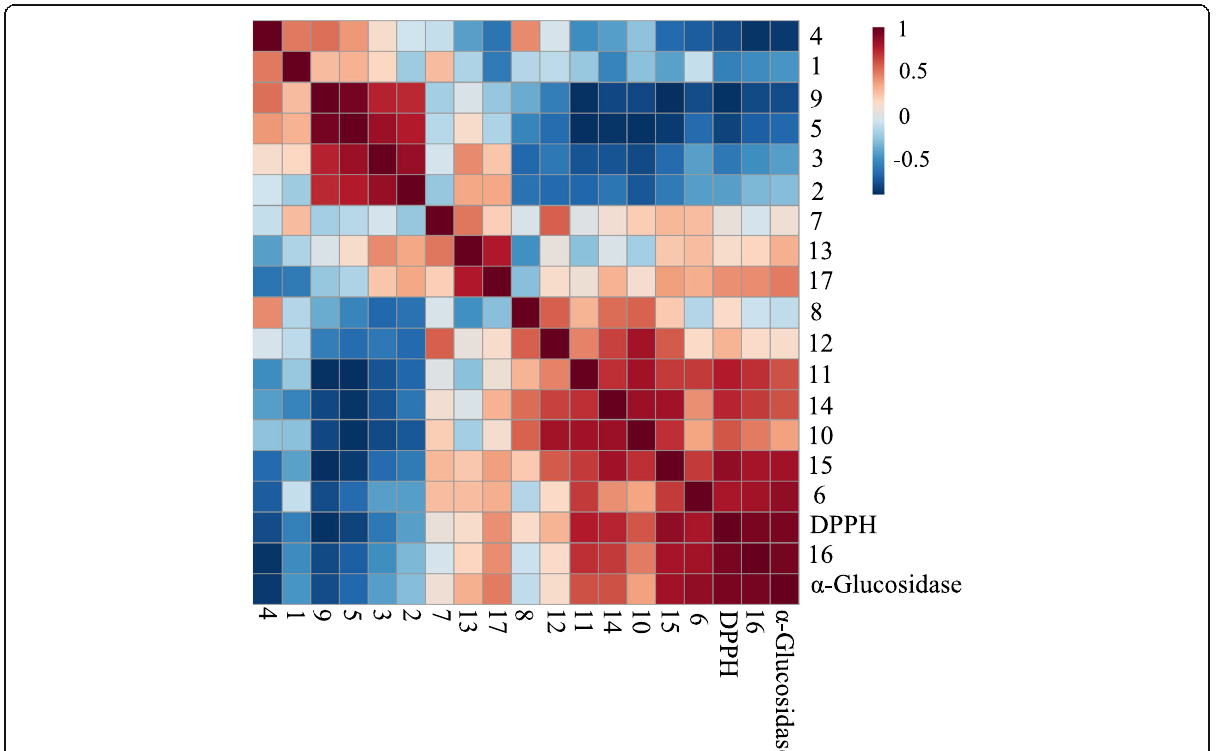
Fig. 6 The overall Pearson ’ s correlation between the metabolites and bioactivities of different fractions of N. oleracea . The value of the correlation coefficients is represented by the blue and red colour intensities. 1, phytosterol; 2, fatty acids; 3, alanine; 4, leucine; 5, valine; 6, α -glucose; 7, β -glucose; 8, fructose; 9, oleanolic acid; 10, quercetin derivatives; 11, kaempferol derivatives; 12,apigenin derivatives; 13, myricetin derivatives; 14, gallic acid; 15, 3,4- O -dimethylgallic acid; 16, caffeic acid; 17,